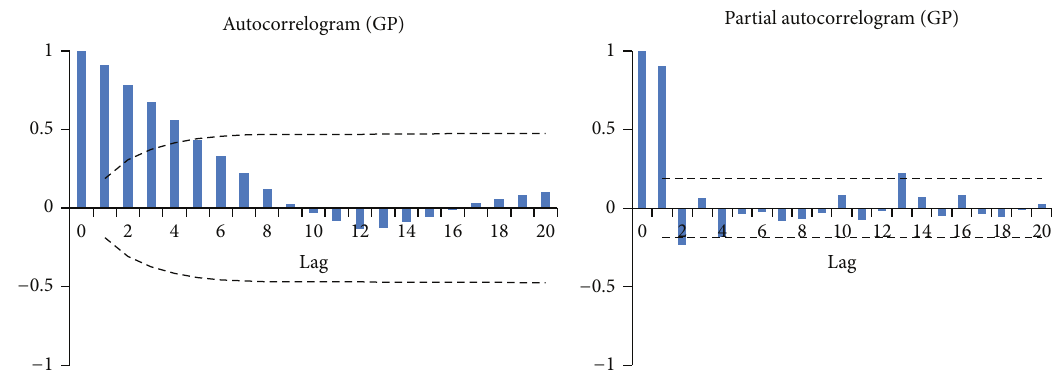
Figure 7: The autocorrelogram and partial autocorrelogram of GP after descriptive analysis.